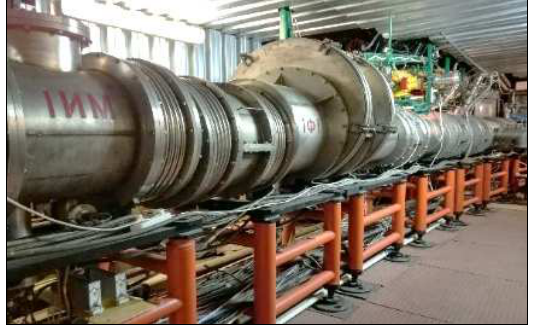
Figure 1. The Nuclotron